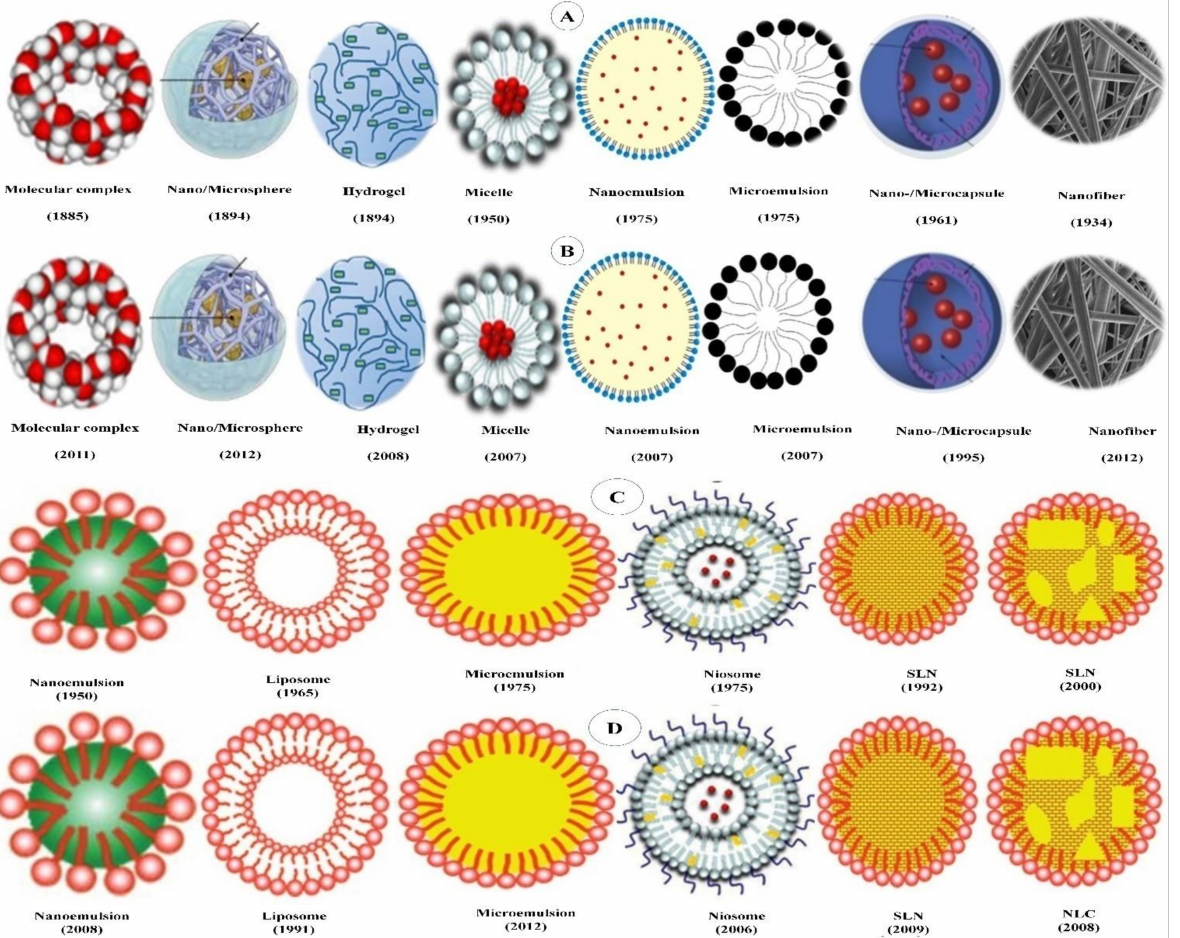
Figure 3. ( A ) Historical event in the evolution of polymer-based delivery systems; ( B ) historical event in the application of polymer-based delivery system for encapsulating β -carotene; ( C ) historical event in the evolution of lipid-based delivery systems; ( D ) historical event for applying lipid-based delivery system for encapsulating β